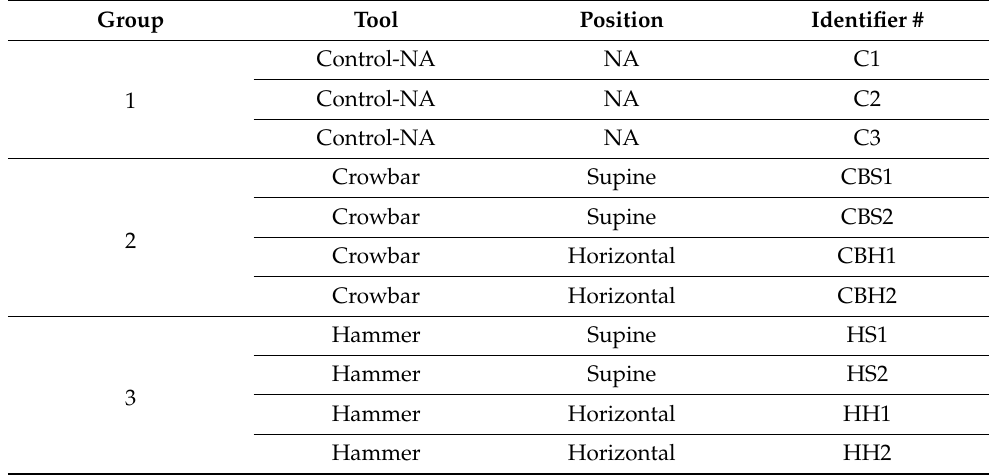
Table 1. Sample distribution. Tool column indicates classification of instrument used during manual trauma. Position lists skull pose during trauma. Identifier # lists the classification system assigned to samples throughout